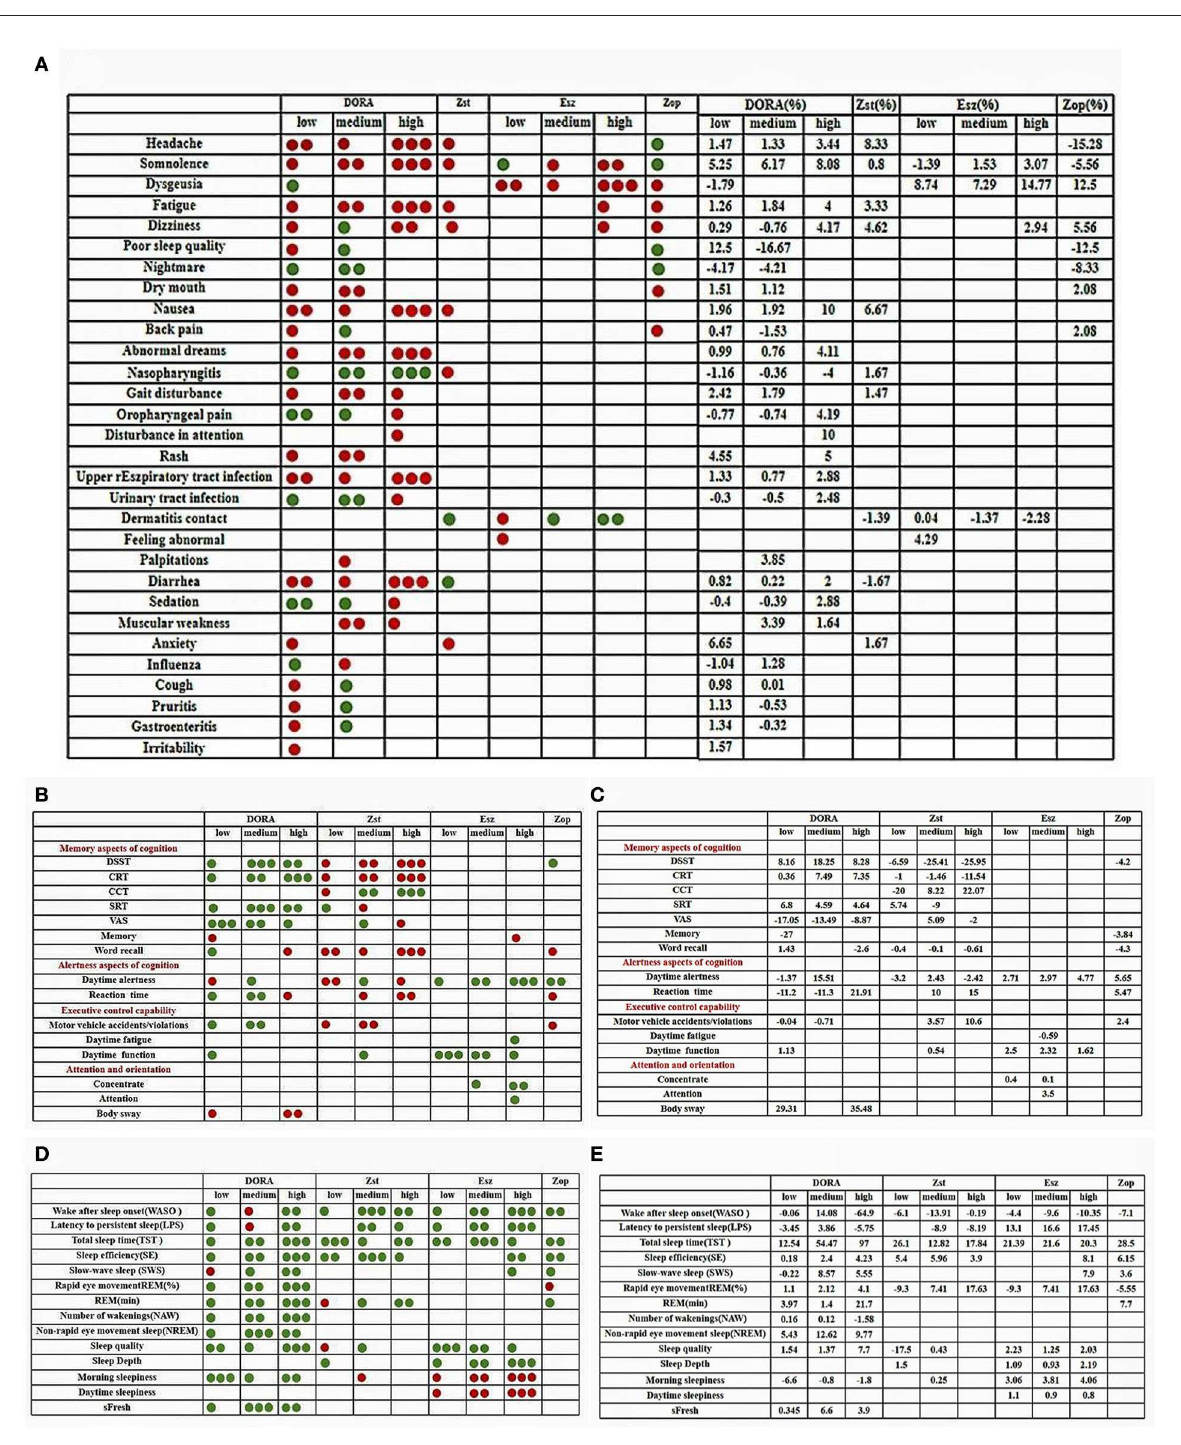
FIGURE3 (A–E) Color contrast quality evaluation chart. The evaluation method of each related index is to evaluate the clinical treatment effect of the subject. The green point is to improve and have a positive effect. The red point is to damage, reduce, and produce negative harm. The number of points is evaluated according to the numerical value. The larger the numerical value, the more the number of